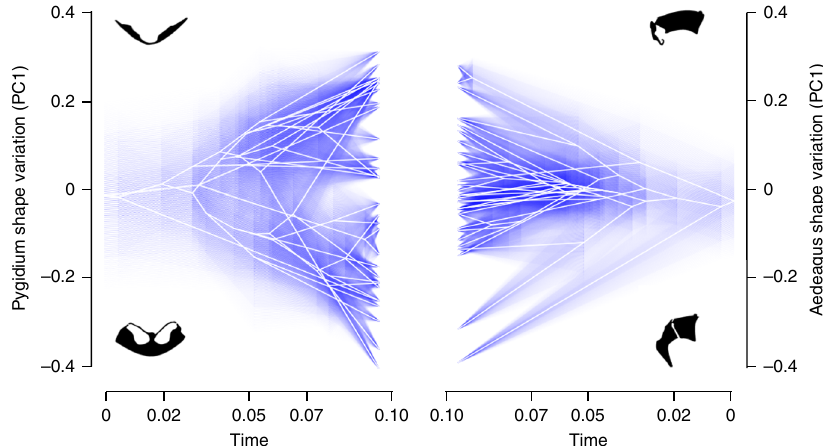
Fig. 2 Comparing male and female genital evolution over time. Traitgrams projecting the onthophagine phylogeny into a space de fi ned by pygidium (left) and aedeagus (right) shape variation over time. The y-axis represents descriptions of multivariate genital shape obtained from the fi rst principal component (PC1) of size-normalized Fourier coef fi cients for female and male genitalia plotted against the relative time from the root of the phylogeny. Traitgrams illustrate greater variation (i.e., more divergence in multivariate shape space) in pygidium shape among closely related species compared to variation in aedeagus shape. Uncertainty around ancestral states over time is depicted such that increasing transparency of the blue lines indicates increasing ancestral state uncertainty. Shape variation is illustrated with outlines from species at opposite ends of multivariate pygydium ( O. aeruginosus + ve; O. binodis -ve) and aedeagus ( O. aeruginosus + ve; O. nigriventris -ve) trait space